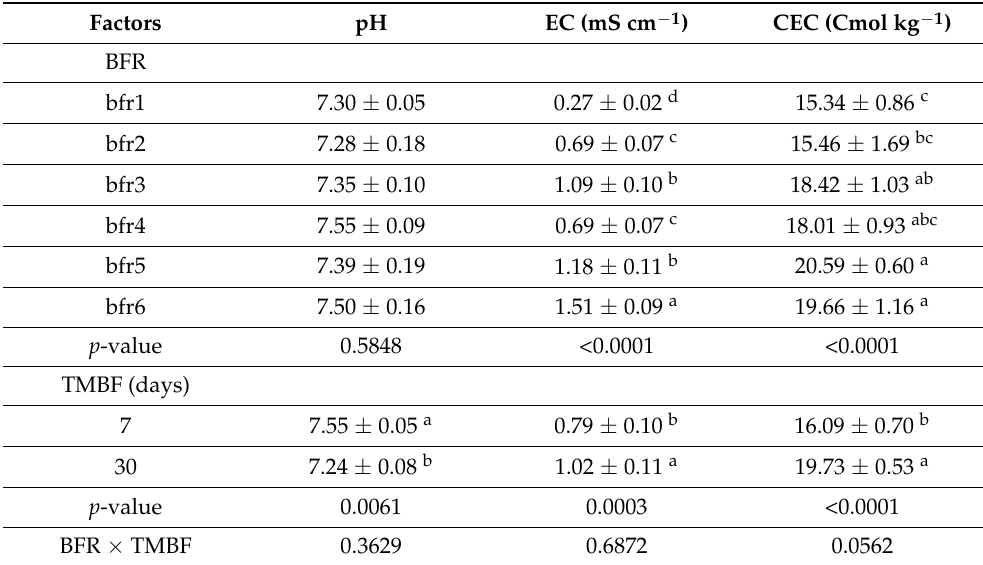
Means followed by the same letter(s) in the same column are not significantly different ( p > 0.05) using Tukey’s HSD at 5% ± standard error. EC = electrical conductivity, CEC = cation exchange capacity, BFR = bokashi fertilizer ratio. TMBF = time of maturation of bokashi fertilizer. bfr1 = (80% HBW:0% CD:20% PHC), bfr2 = (80% HBW:10% CD:10% PHC), bfr3 = (70% HBW:20% CD:10% PHC), bfr4 = (70% HBW:10% CD:20% PHC), bfr5 = (60% HBW:20% CD:20% PHC), bfr6 = (60% HBW:25% CD:15% PHC). HBW = horse bedding waste, CD = cow dung, PHC = paddy husk